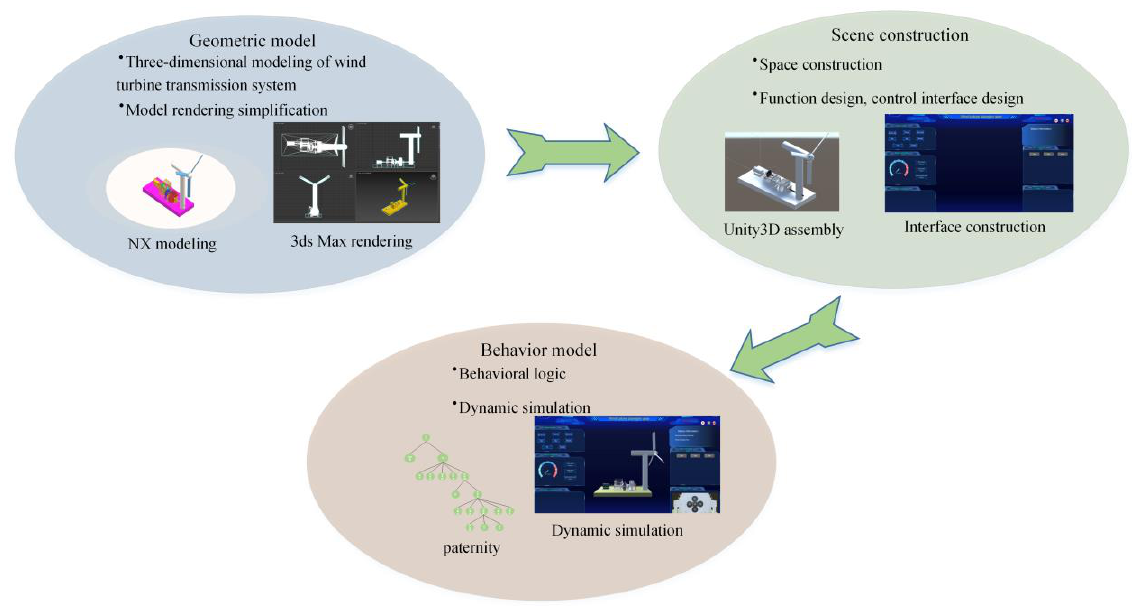
Figure 3. Establishment of the digital twin model of the wind turbine drive system.